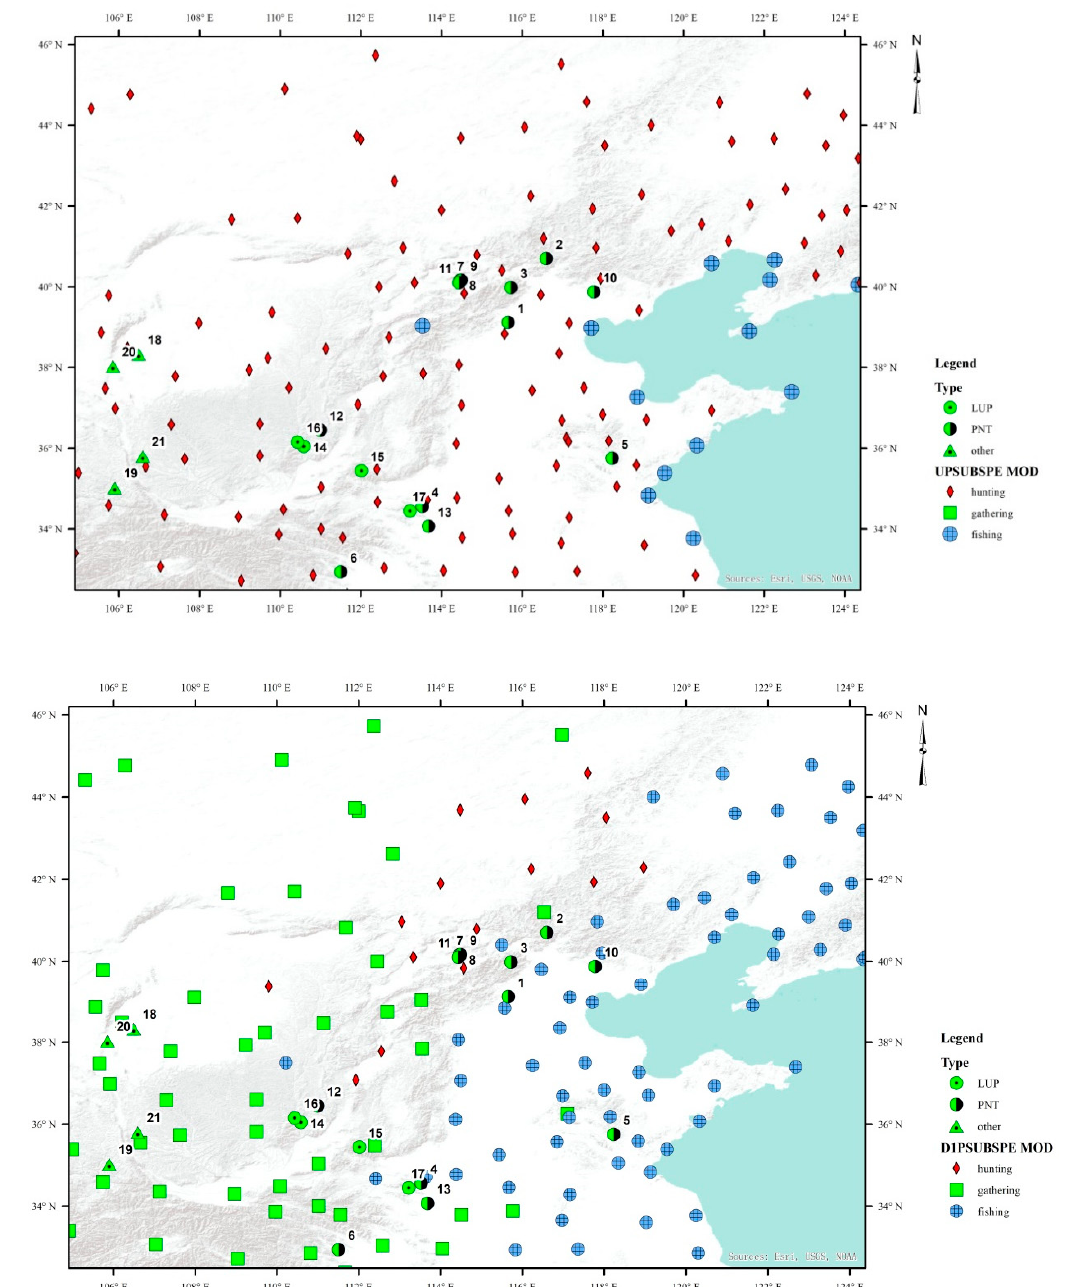
Figure 11. Archaeological sites dated to the Pleistocene to Holocene transition on the maps of projected unpacked and packed hunter – gatherer subsistence specialty (UPSUBSPE and D1PSUBSPE) in northern China under modern climatic